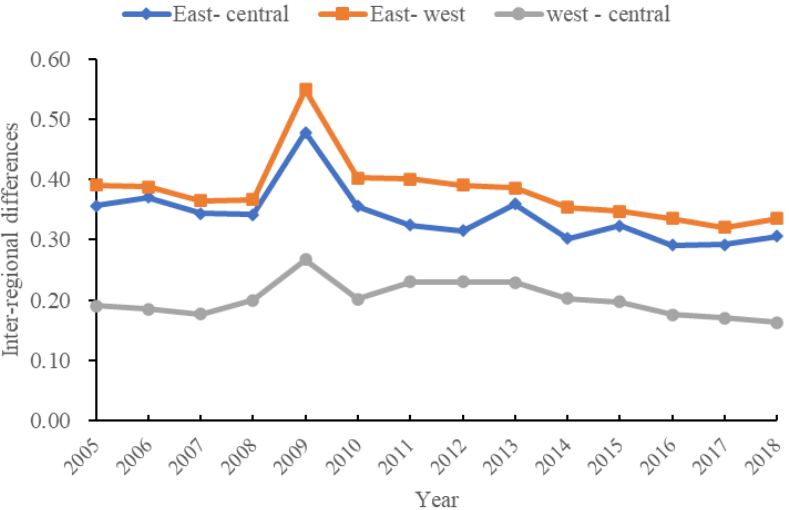
Figure 3. Inter-regional differences in industrial green technology innovation efficiency (GTIE) from 2005 to 2018.